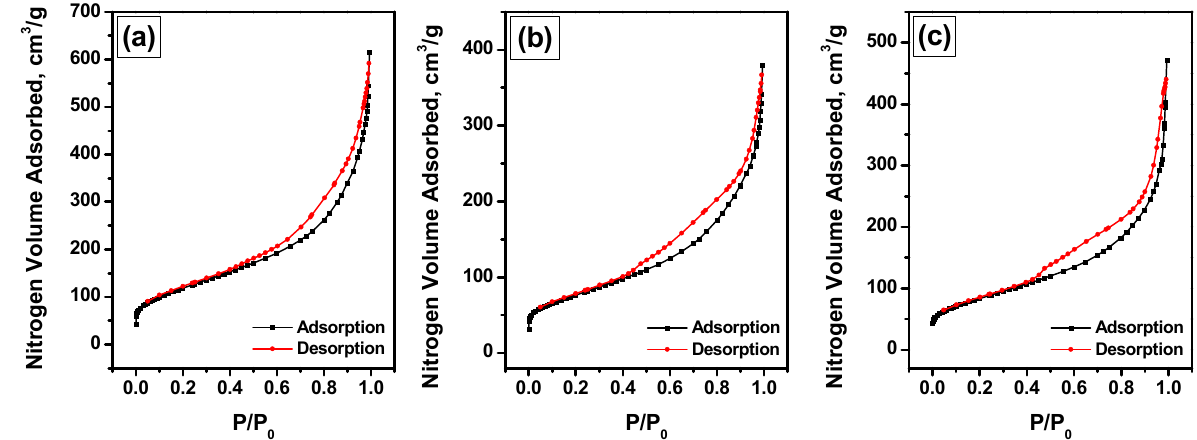
Figure 4. Low-temperature nitrogen adsorption/desorption isotherms of the carbon product obtained in different reactors: ( a ) reactor #1; ( b ) reactor #2; ( c ) reactor #3.